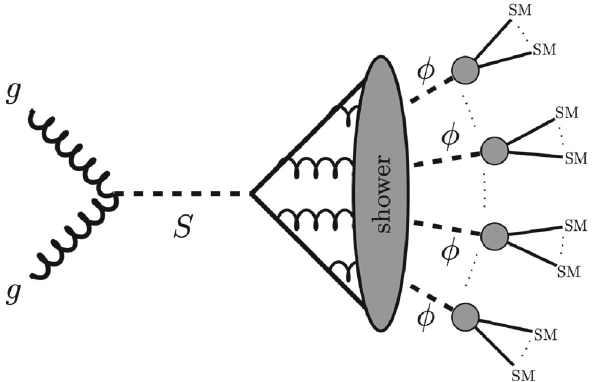
Fig. 15 A visualization of a generic SUEP event. A heavy scalar S accesses a confining HV and showers into light mesons (e.g. π D , here denoted φ ) before decaying to SM particles. Figure adapted from Ref.